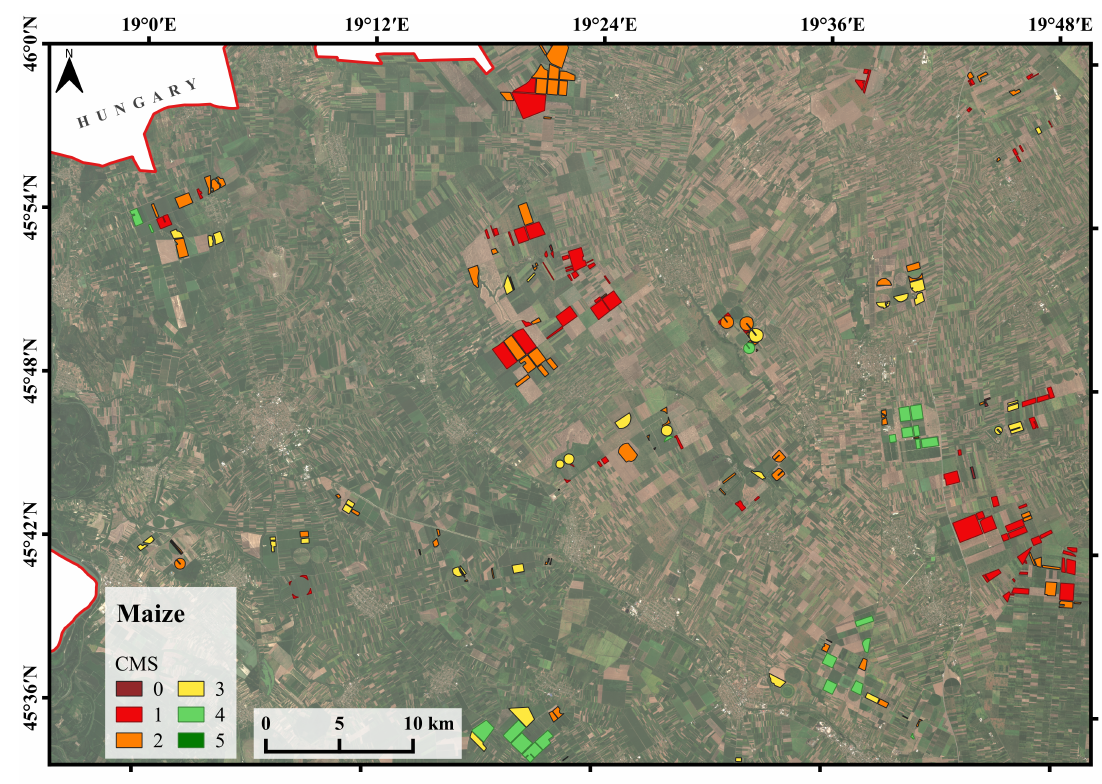
Figure 5. Map of maize fields with CMS classes for 2022.